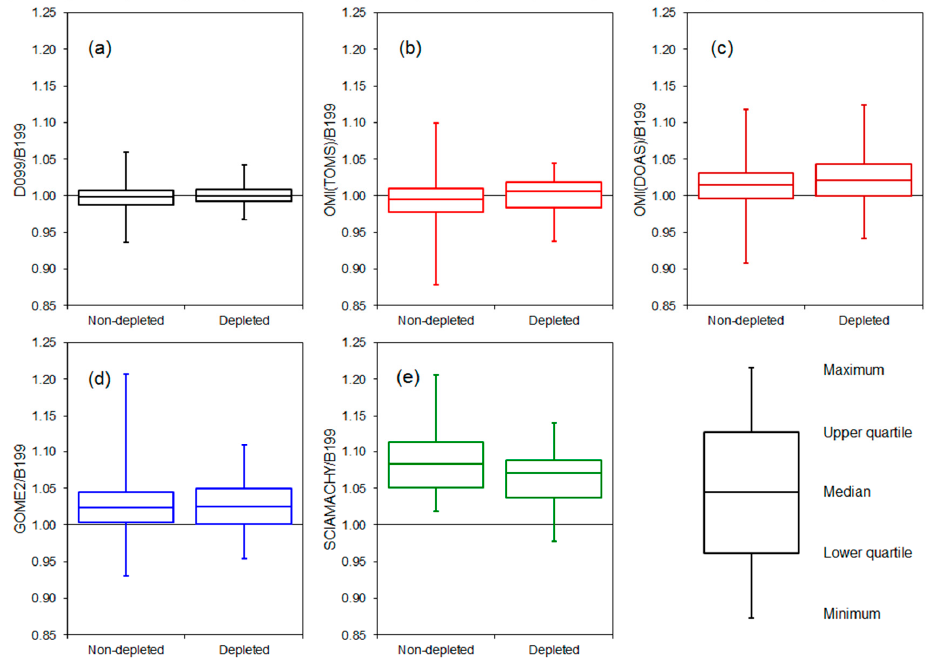
Figure 5. Monthly ( a ) bias, ( b ) MAE, ( c ) RMSE, and ( d ) determination coefficient R 2 of the D099 and the satellite TOC observations relative to the B199 TOC at the Marambio Base for the period 2011– 2013.